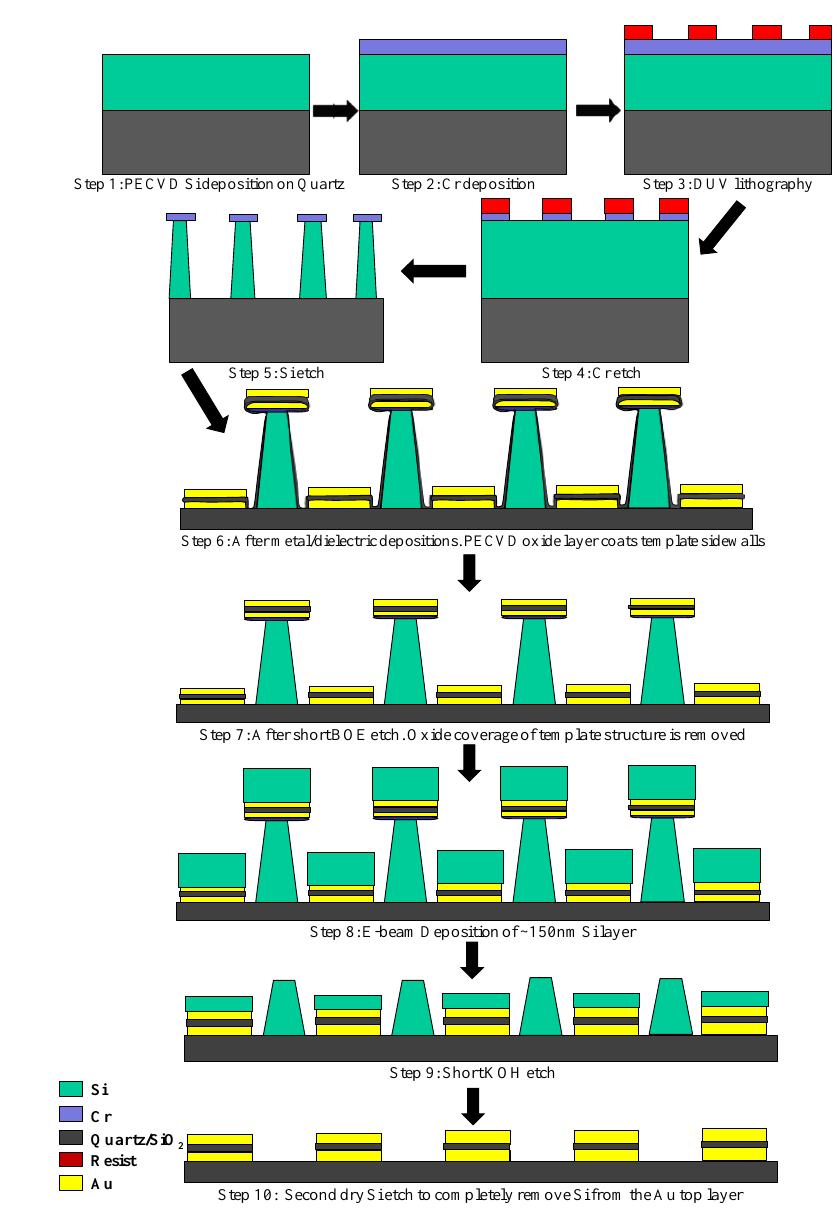
Figure 3. The fabrication